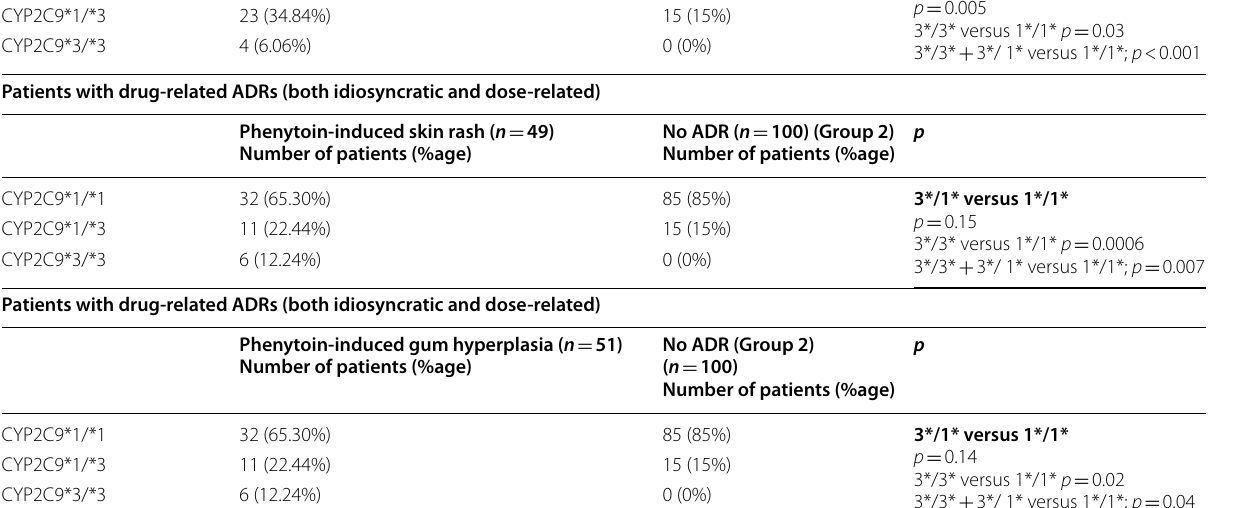
Bold values are significant when p -value is < 0.05